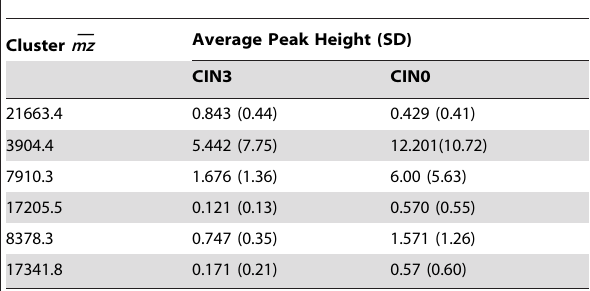
Table 4. CIN0 vs. CIN3 group tests (Mann-Whitney) based on peak height measurements under stringent condition (S/N 5/ 3) using Ciphergen Express.